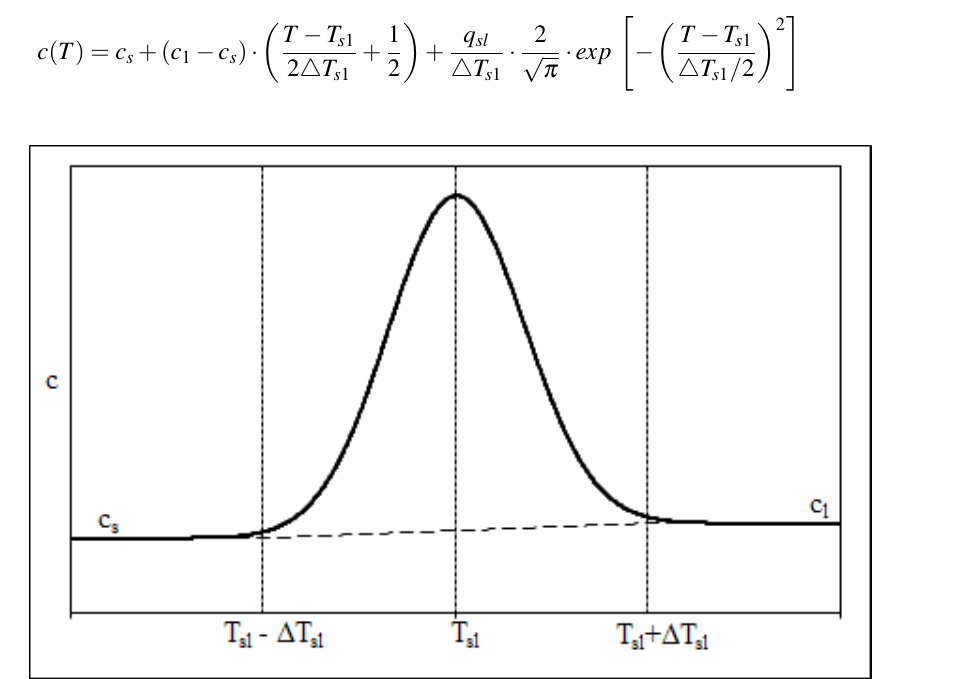
Figure 4. Effective specific heat of the